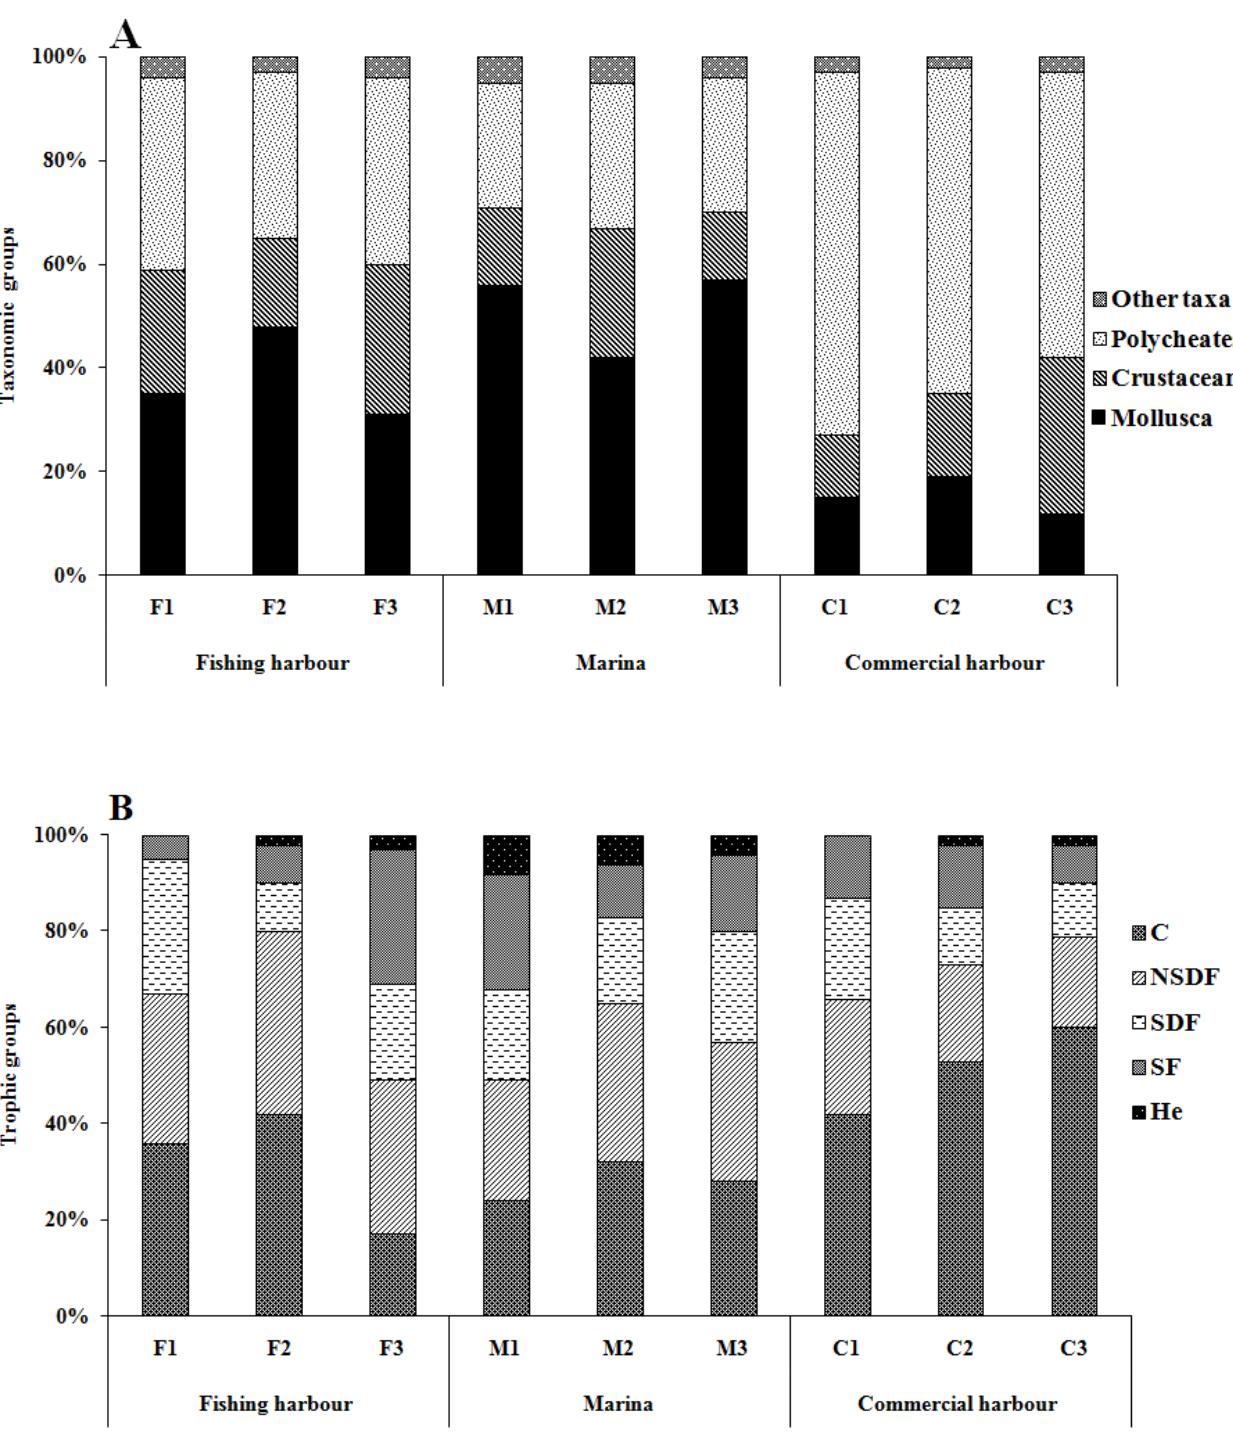
Figure 4. Proportion of taxonomic ( A ) and trophic groups ( B ) of the macrobenthic communities sampled in each harbour. C: carnivores, He: micrograzers, SF: suspension feeders, SDF: selective deposit feeders, NSDF: non selective deposit feeders.